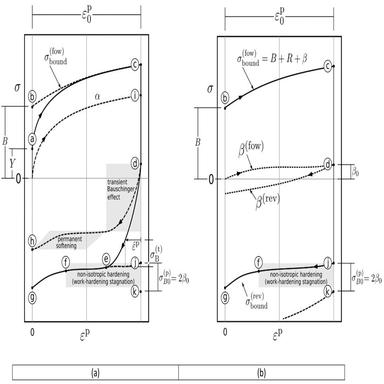
A schematic of the changes in the true stress, σ, and true plastic strain,εp, (a) yield surface and (b) bounding surface (solid lines) during a uniaxial tensioncompression test (Y-U).